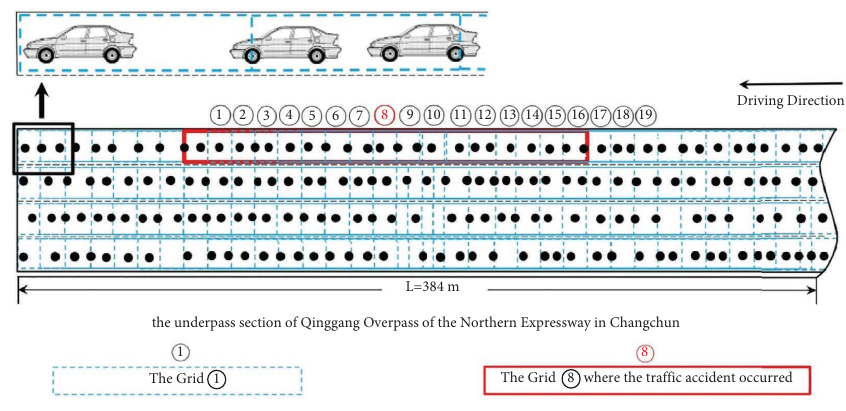
Figure 3: Te case study section and unit